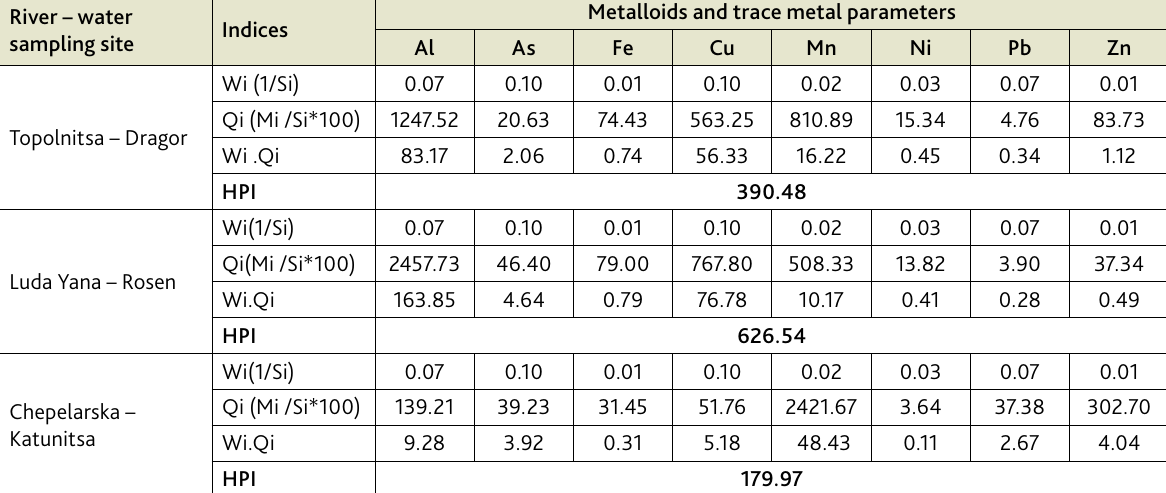
Table 8. Obtained ratings of the HPI and basic statistics used in the calculations River –